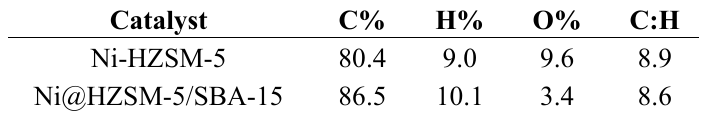
Table 4. Elemental analysis of oil products with vario EL III elemental analyzer.